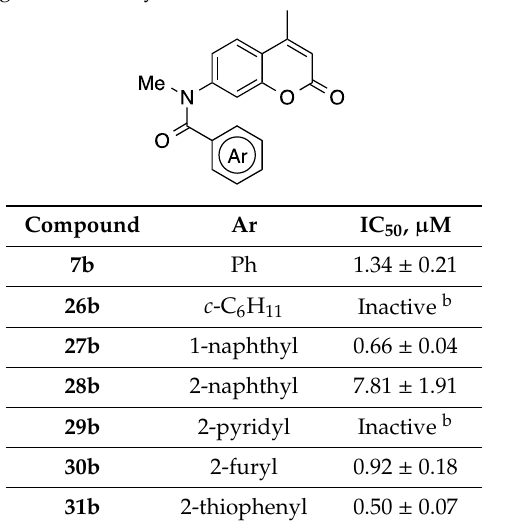
Table 3. AR-antagonistic activity of coumarinamide derivatives in SC-3 cell assay a .